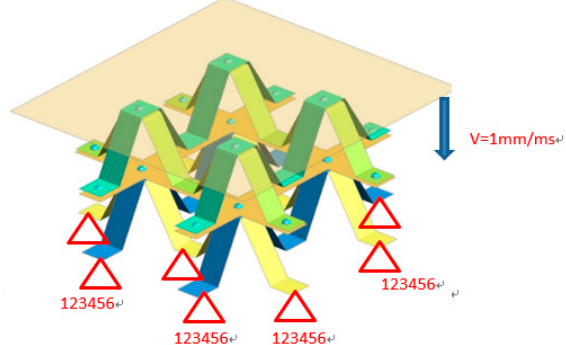
Figure 9. The quasi-static collapse simulation model of memory alloy combination double layer module.